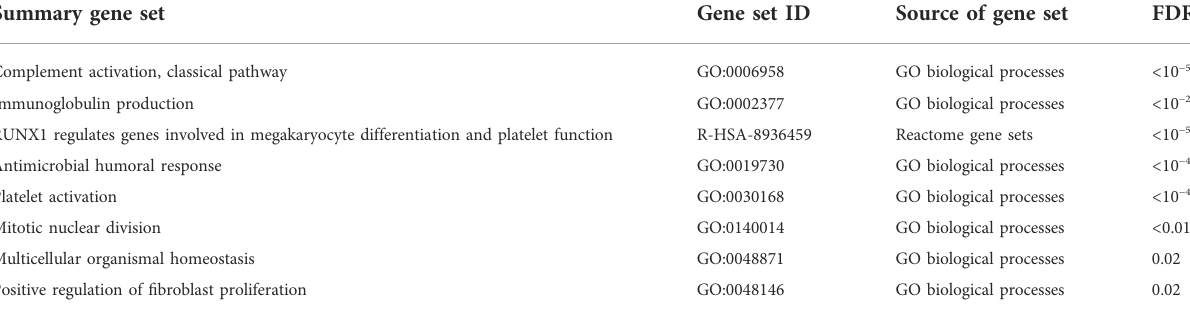
TABLE 2 Functionally enrichedgenesets among the COVID-19speci fi csignature. Summary gene setsat false discovery rate(FDR) of0.05are